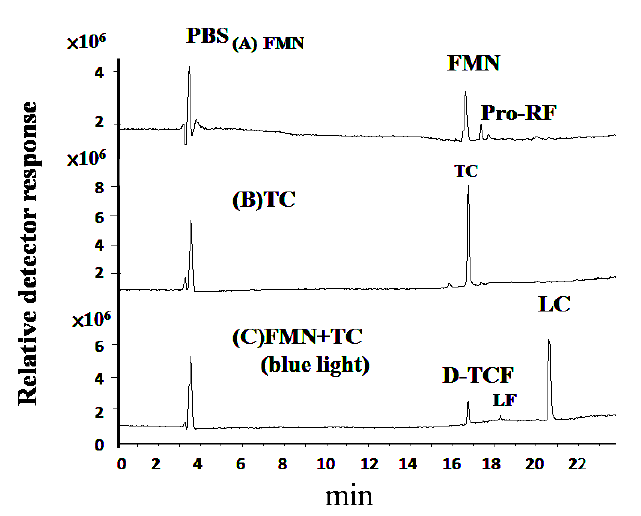
Figure 7. The chromatograms of the HPLC-MS analyses of ( A ) FMN (pH 7.8), ( B ) 50 μ g/mL of TC solution, and ( C ) 50 μ g/mL of TC in FMN solution after 20 W/m 2 blue light irradiation at 25 ± 3 °C for 1 h. PBS: phosphate buffer solution. Notice that the Pro-RF in ( A ) coeluted with FMN is confirmed as riboflavin and described in the Results section.